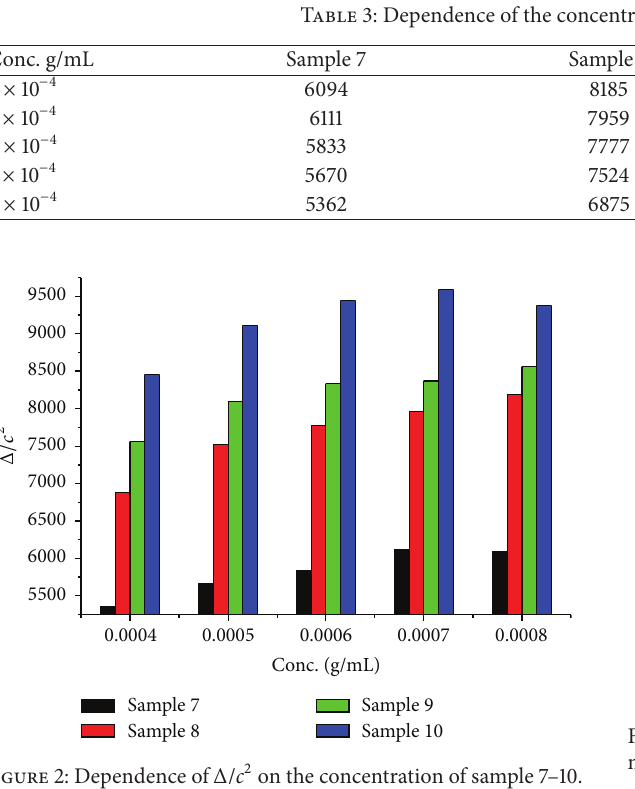
Table 2: Dependence of the flow time, relative viscosity, specific viscosity, Δ = 𝜂 Conc. (g/mL)